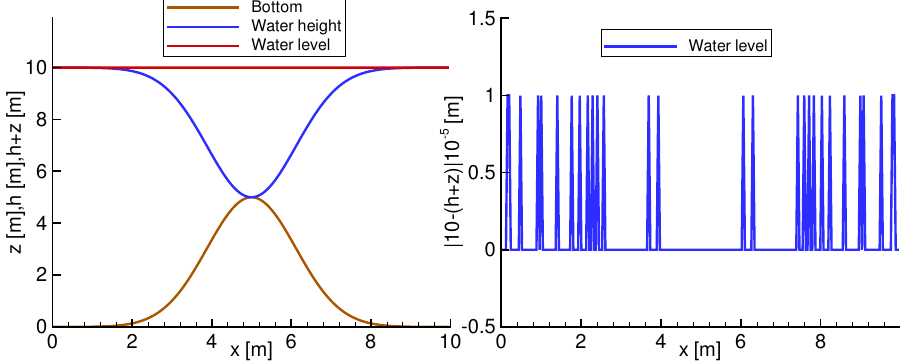
Figure 1. Numerical solution of water height and depth of the lake at rest with an overview of the